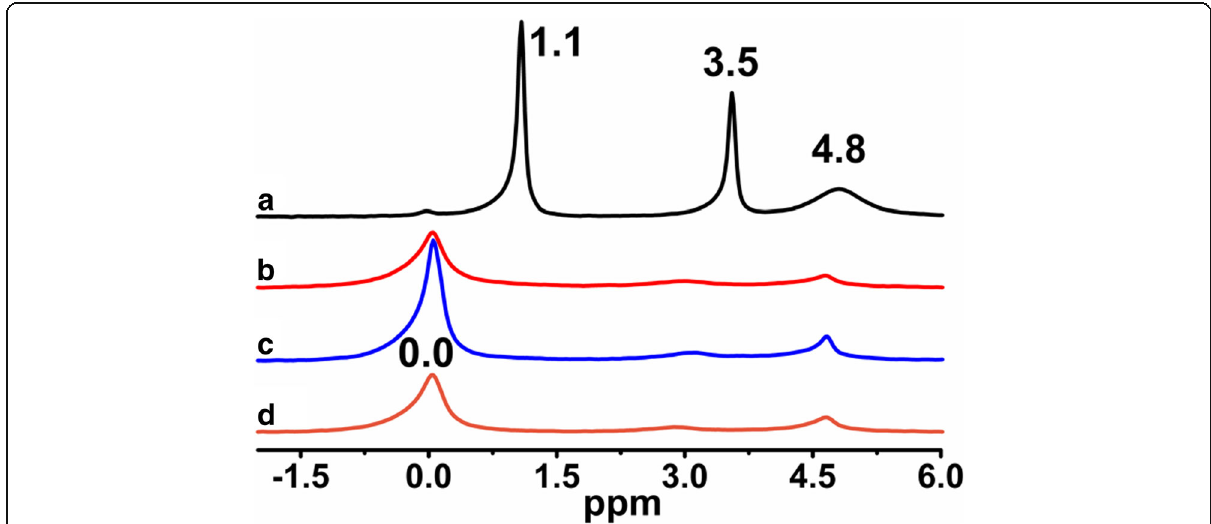
Fig. 1 1 H MAS NMR spectra of ( a ) neat fumed silica, ( b ) modified fumed silica with PMHS, modified with ( c ) mixtures of PMHS and dimethyl carbonate and ( d ) mixtures of PMHS and diethyl